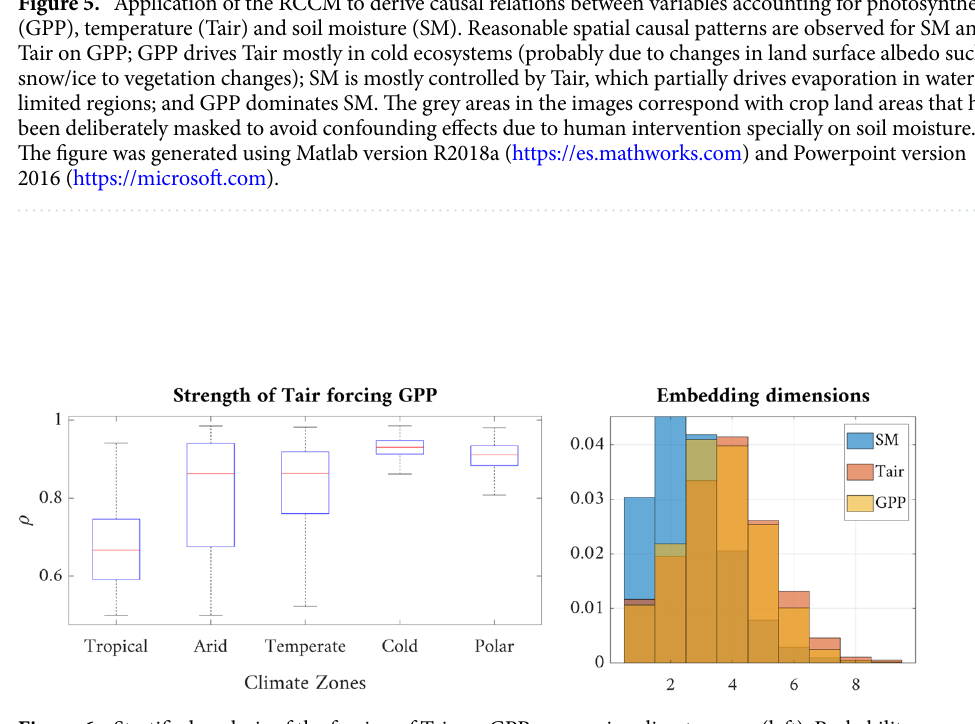
Figure 6. Stratified analysis of the forcing of Tair on GPP over major climate zones (left). Probability distribution of the pixel-wise dimensionality of the embedding computed with the proposed RCCM approach